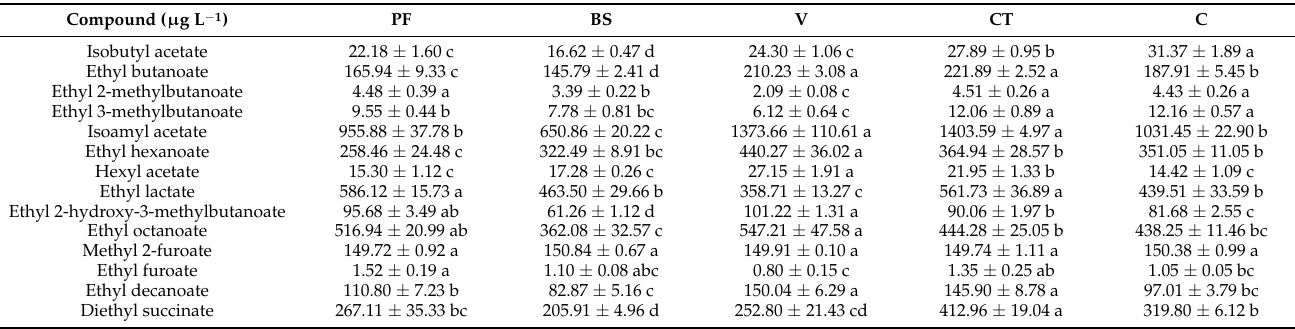
Table 3. The concentration of fermentation aromas in Maraština wines subjected to defoliation and cluster-thinning